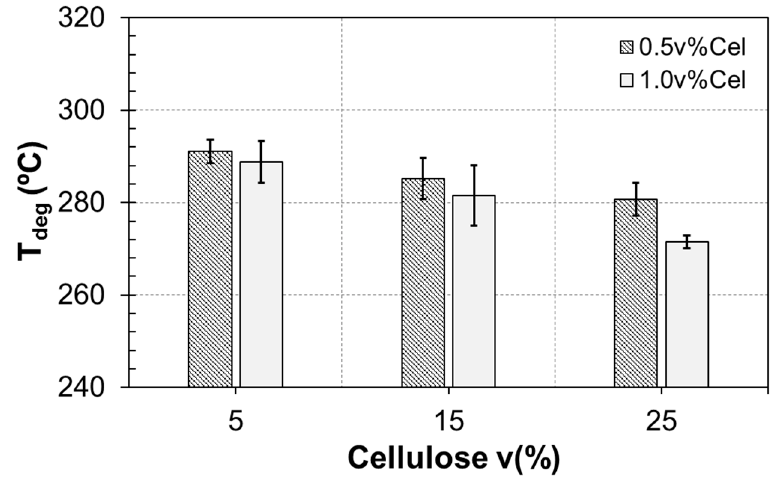
Figure 1. Thermogravimetric analyzer (TGA) analysis for bio-composites made of 1.5 v% chitosan and 0.5 v% and 1.0 v% cellulose using 1.25 v% of acetic acid.